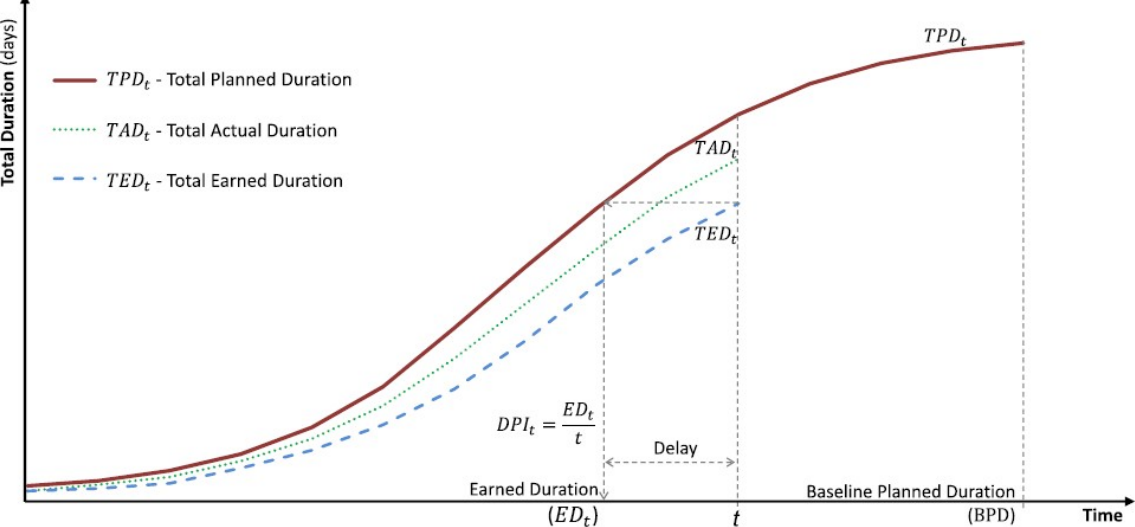
Figure 2. Earned duration management metrics. Reprinted with permission from ref. [22]. Copyright 1983 American Society of Civil Engineers.